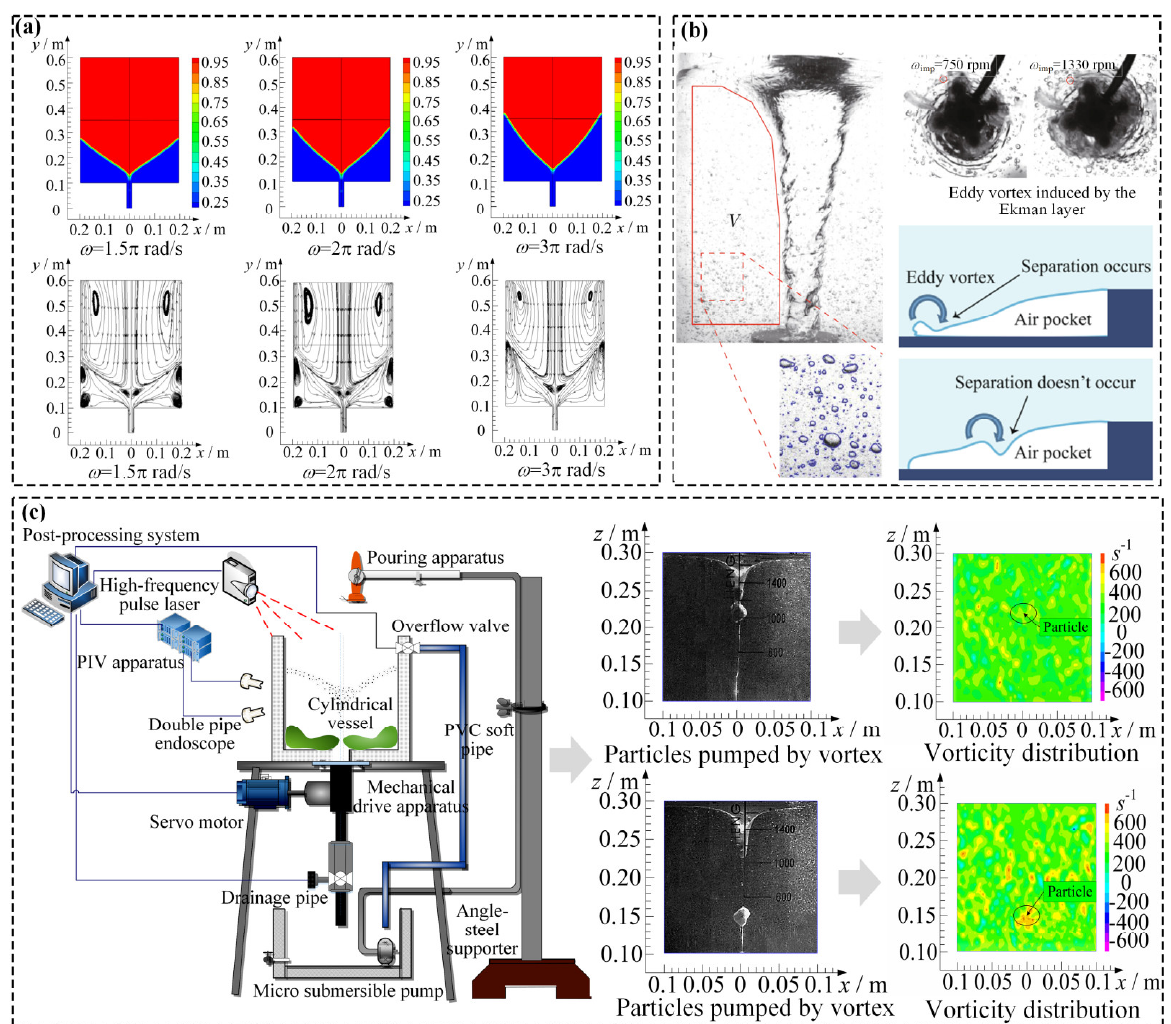
Figure 8. Flow field characters of two-phase sink vortex. ( a ) Volume fraction and streamline distribution. (Reprinted with permission from Ref. [74]. 2020, Elsevier.) ( b ) Separation process of the eddy vortex. (Reprinted/adapted with permission from Ref. [75]. 2021, Chemical Engineering Science.) ( c ) Evolution laws of particles pumped by vortex. (Reprinted with permission from Ref. [74]. 2020, Elsevier.)